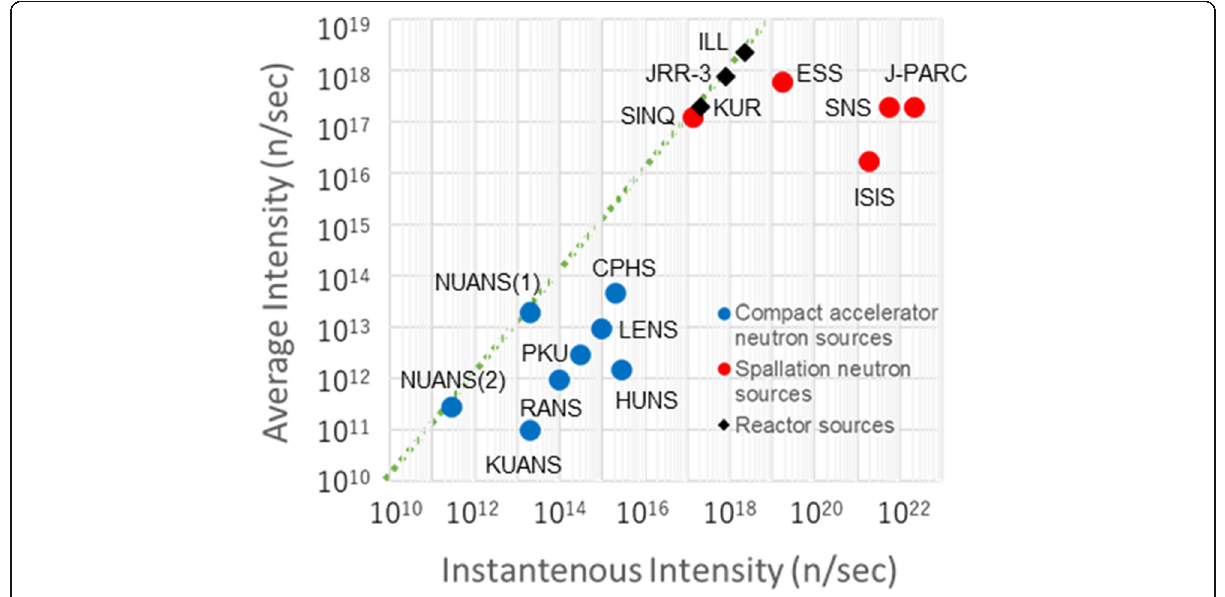
Fig. 5 Average and instantaneous neutron intensities of accelerator-driven neutron sources